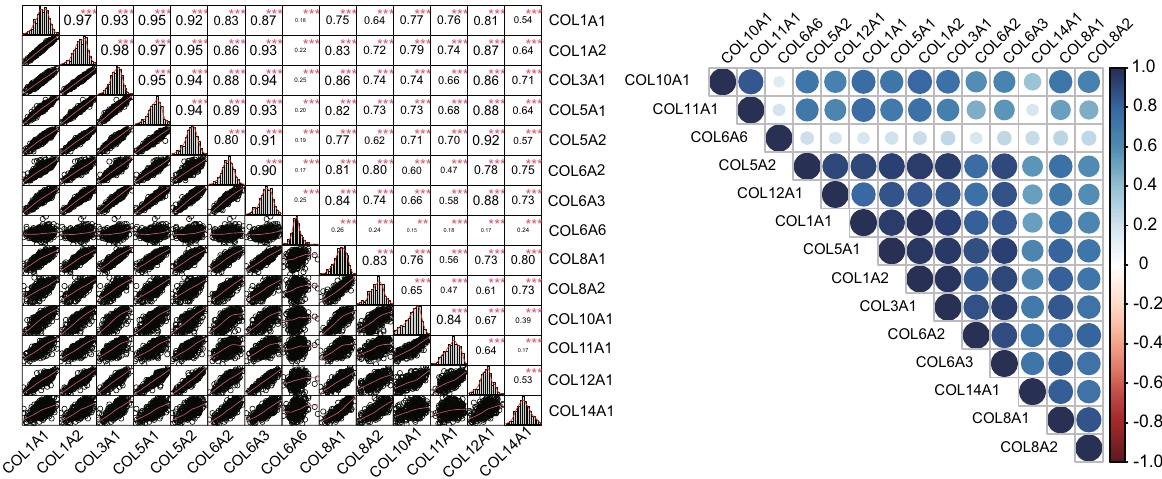
Figure 4. Correlation among the 14 up-regulated collagen genes between T1 and T2 stage in GC tumor tissue. Within the figure, the left part represented the scatter plot and matching correlation values from − 1 to 1, whereas the right part showed the correlation strength in different color and the statistical significance in different knowledge, the correlation between the expression of collagen genes have not been reported before. Differential expression analysis by edgeR and Wilcoxon test identified 14 collagen genes that were differentially expressed between T1 and all the other three T stages. Compared with T1 stage, the mRNA expressions of the 14 collagen genes in T2, T3, and T4 stages were all up-regulated. Correlations between the mRNA expression of the 14 col- lagen genes in GC samples was analyzed by spearman correlation analysis. As exhibited in Fig. 4, significant and positive relationships existed among all of the 14 genes. High correla- tions were found among COL1A1, COL1A2, COL3A1, COL5A1, COL5A2, COL6A2, and COL6A3, with PCC values larger than or close to 0.9. Interestingly, the correlations between COL6A6 and other genes were weak (PCC < 0.3). The correlation analysis of these 14 collagen genes based on GSE84437 dataset in GEO database gave similar results (see Supplementary Fig. S4 online). Correlation among the 9 down-regulated collagen genes in GC tumor was also analyzed, and the results showed that a strong positive correlation existed between the mRNA expression of COL4A5 and COL4A6 (see Supplementary Fig. S5 online).